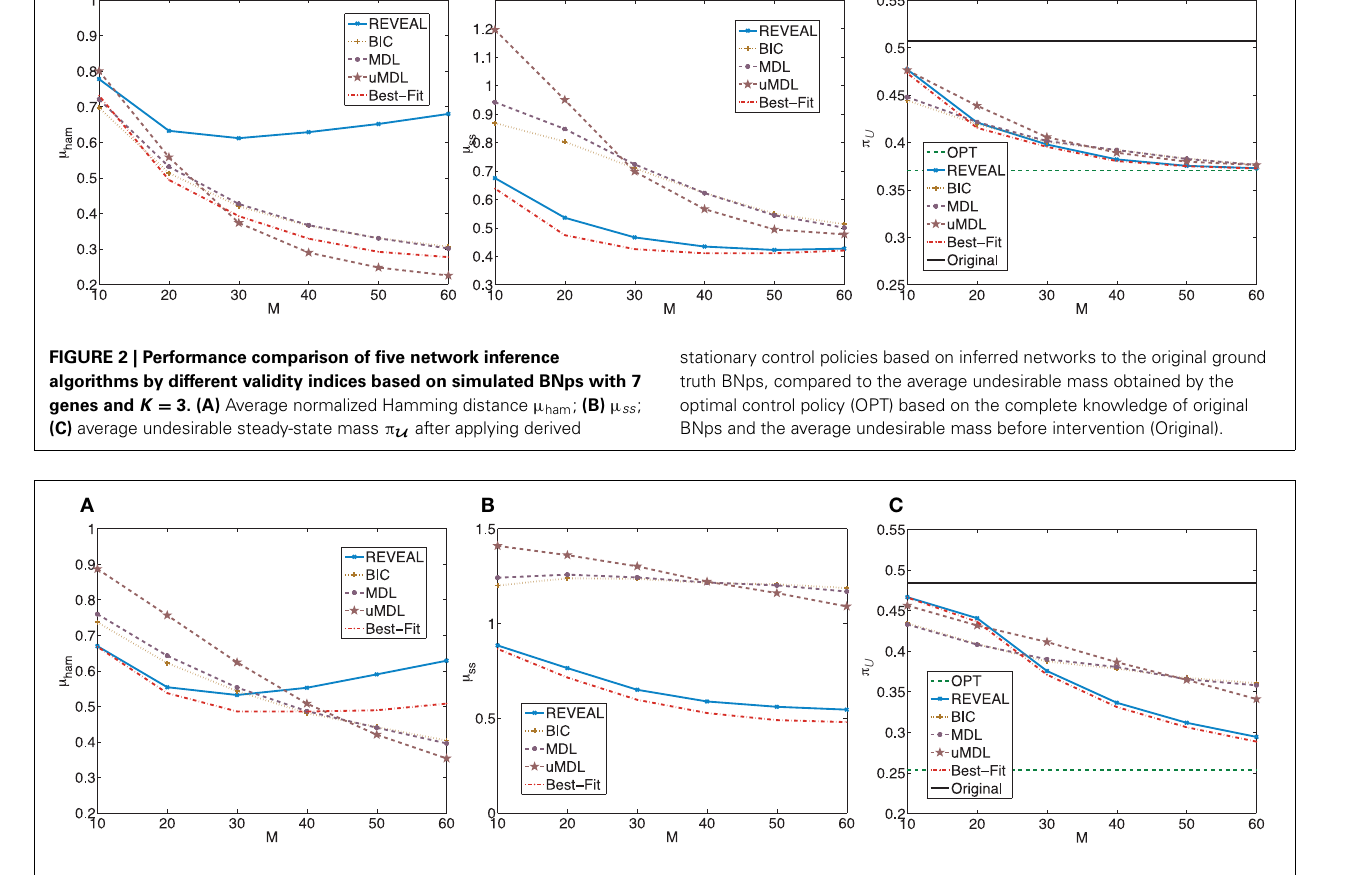
stationary control policies based on inferred networks to the original ground truth BNps, compared to the average undesirable mass obtained by the optimal control policy (OPT) based on the complete knowledge of original BNps and the average undesirable mass before intervention